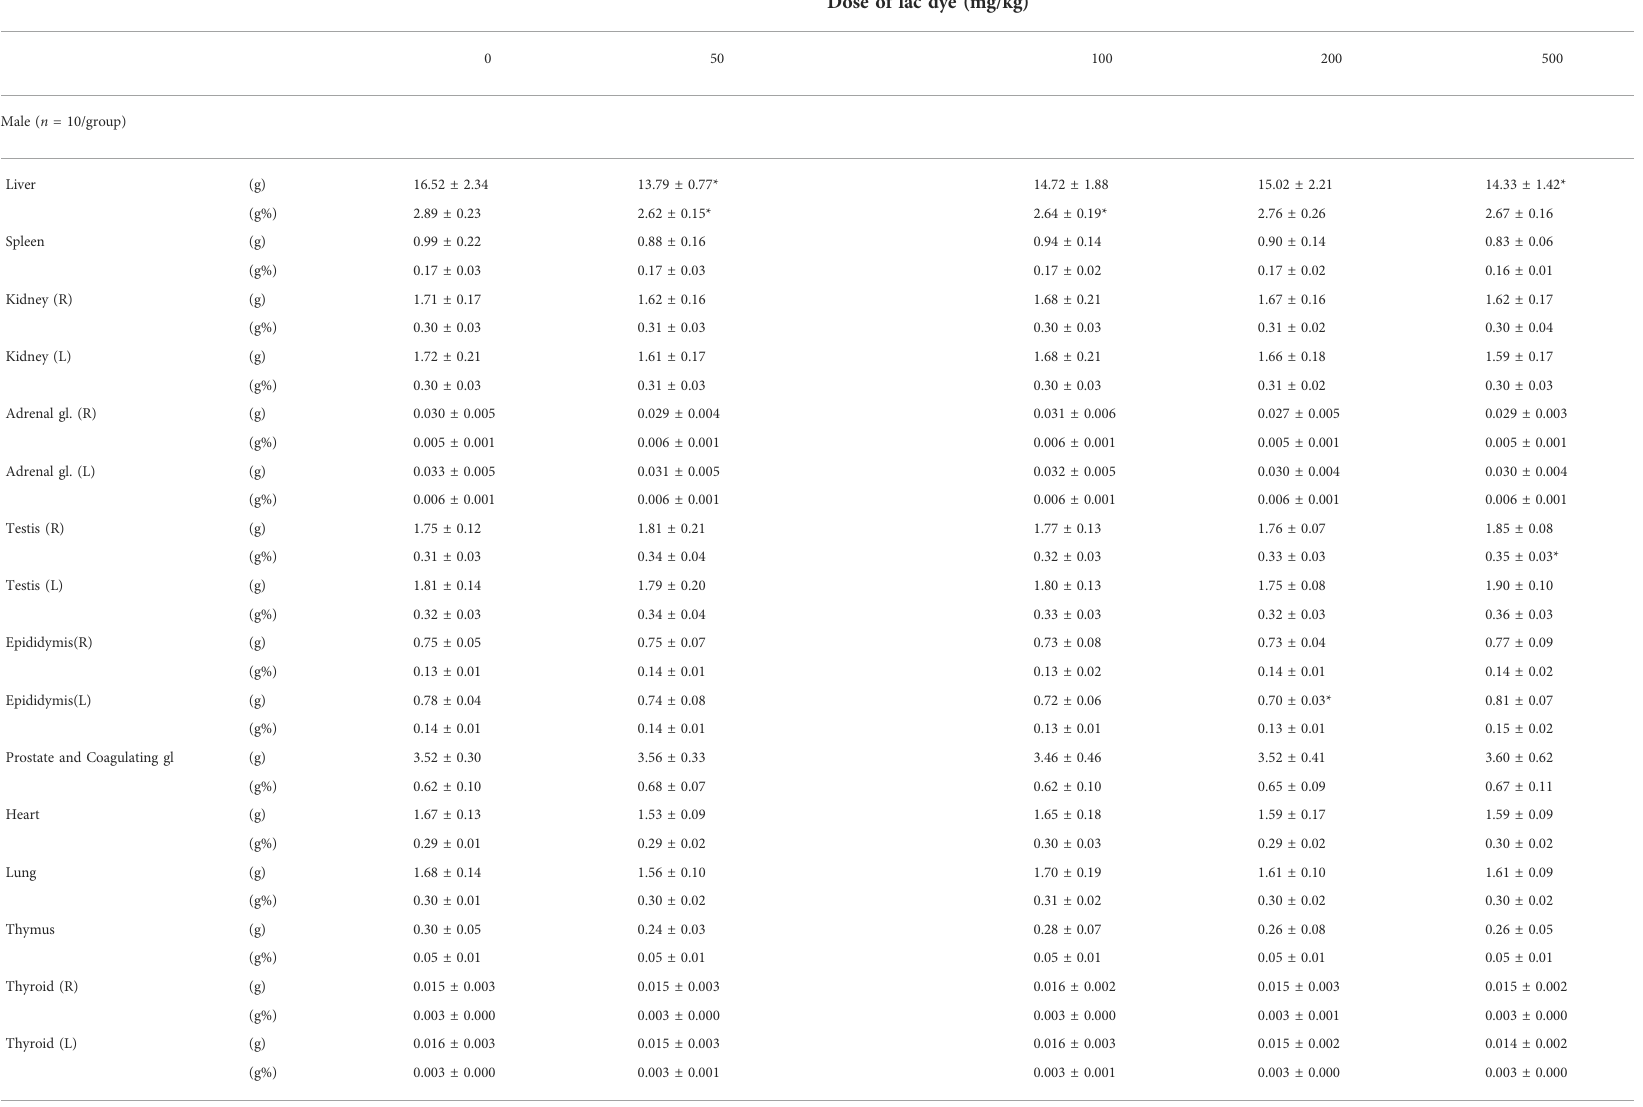
TABLE 3 Absolute and relative weight of major organs from SD rats orally treated with lac dye for 90